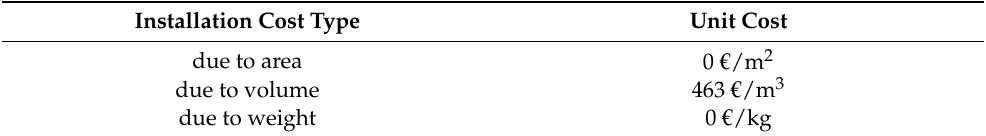
Table 7. Installation unit costs.